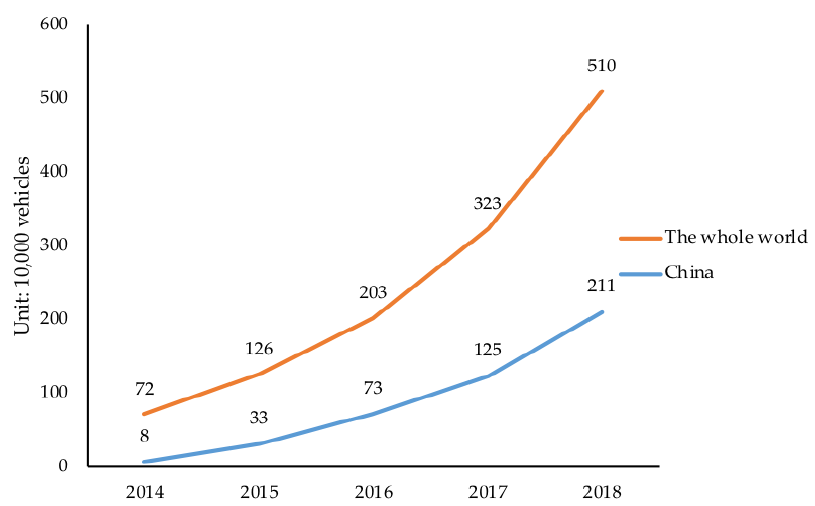
Figure 1. Global and Chinese electric vehicle ownership in the past five years.